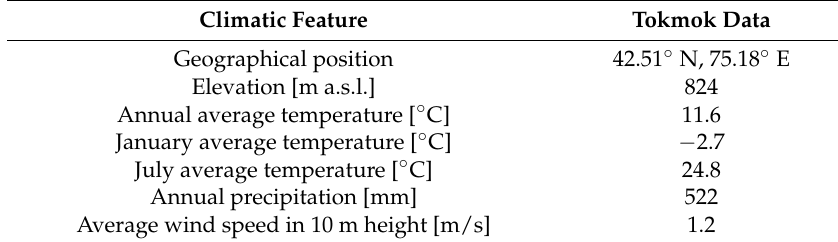
Table 1. Climatic features of Tokmok (https://rp5.ru/Wetterarchiv_in_Tokmok). Data range from 2005 to 2016.